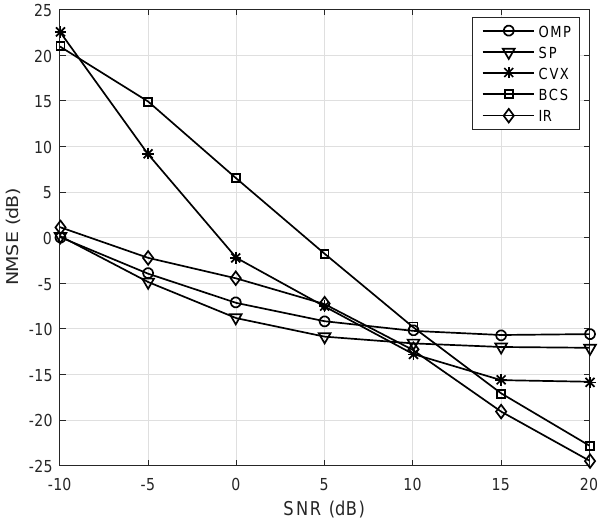
Figure 2. NMSE of the estimated CSI versus received SNR with sparseness L = 5, pilot symbol frames M = 16, angle quantization G = 32 and without hardware